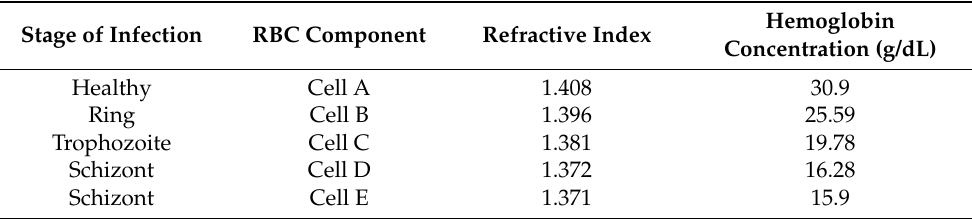
Table 1. Refractive index values of various cells depending upon the hemoglobin concentration within RBCs